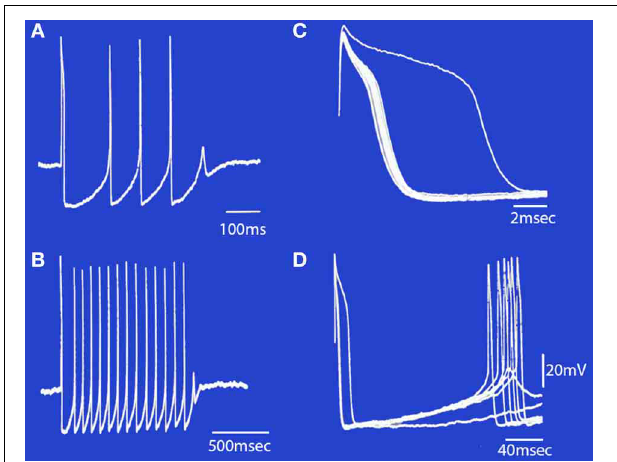
FIGURE 7 | Spontaneous bursts of spikes recorded intracellularly from an IO neuron displayed at different sweep speeds. (A) The neuron fired four action potentials and a fifth subthreshold response that corresponds to a subthreshold somatic Ca 2 + -dependent spike. (B) A longer burst of spikes is shown at a slower sweep speed. Note that the first interspike interval in the burst was longer than the rest. (C) The rising phase of the action potentials in (B) are superimposed to illustrate the change in after-depolarization duration during the train. Note that the first action potential (which arises from the resting membrane potential level) has the longest after-depolarization. The other spikes in the train became progressively shorter until failure of spike generation occurred and the burst terminated. (D) The same set of records as in (B) , showing the duration of the after-hyperpolarization and the rebound somatic Ca 2 + -dependent spikes. (Modified from Llinás and Yarom, 1986).